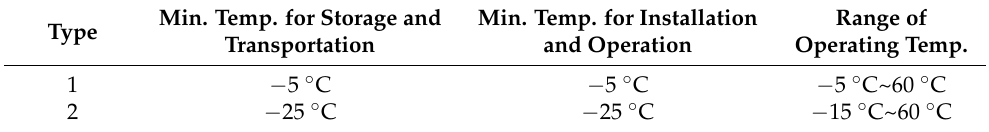
Table 7. Temperature standard of synthetic resin flexible conduit.